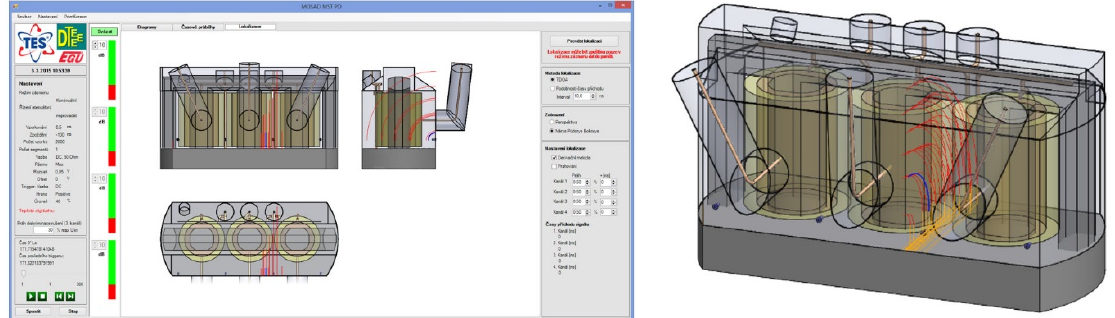
Figure 12. The localization results yielded by the analytical method.